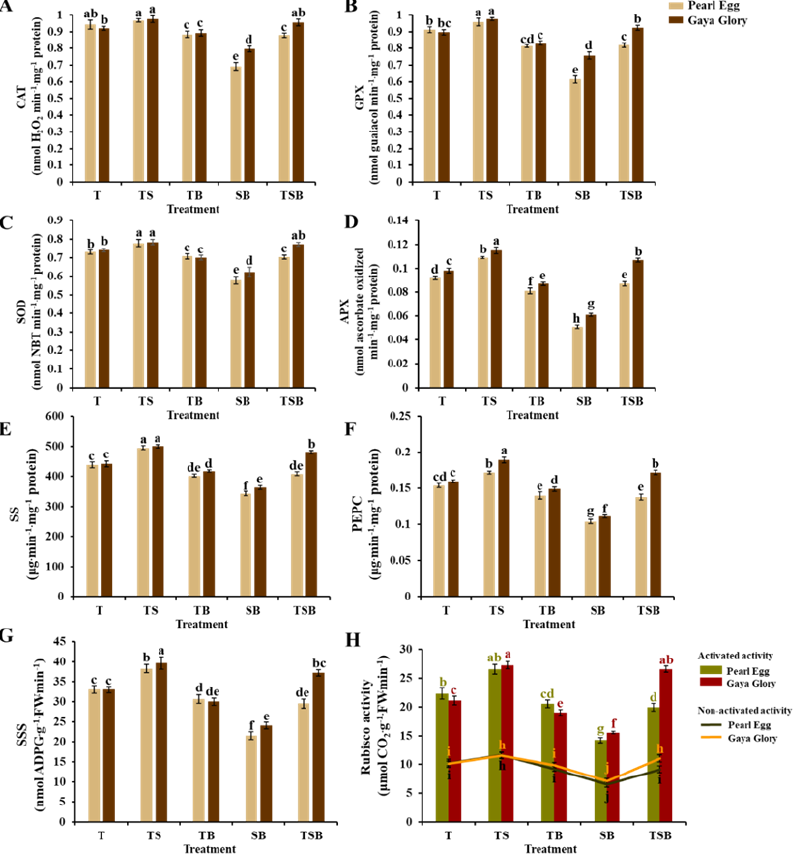
Figure 9. Changes in the enzymatic activities in chrysanthemum “Pearl Egg” and “Gaya Glory” as affected by the different lighting direction combinations after 45 days of cultivation. The ROS scavenging enzymatic activities: Catalase (CAT) ( A ), guaiacol peroxidase (GPX) ( B ), superoxide peroxidase (SOD) ( C ), and ascorbate peroxidase (APX) ( D ). Sucrose synthesis enzymatic activities: Sucrose synthase (SS) ( E ) and phosphoenolpyruvate carboxykinase (PEPC) ( F ). Starch synthesis enzymatic activities: Soluble starch synthase (SSS) ( G ). Photosynthesis enzymatic activities: Activated and non-activated activity of RuBisCO ( H ). T, TS, TB, SB, and TSB, refer top (1/1), top (1/2) + side (1/2), top (1/2) + bottom (1/2), side (1/2) + bottom (1/2), and top (1/3) + side (1/3) + bottom (1/3) lighting, respectively. Vertical bars indicate the means ± standard error ( n = 6). Different lowercase letters indicate significant separations within treatments by Duncan’s multiple range test at p ≤